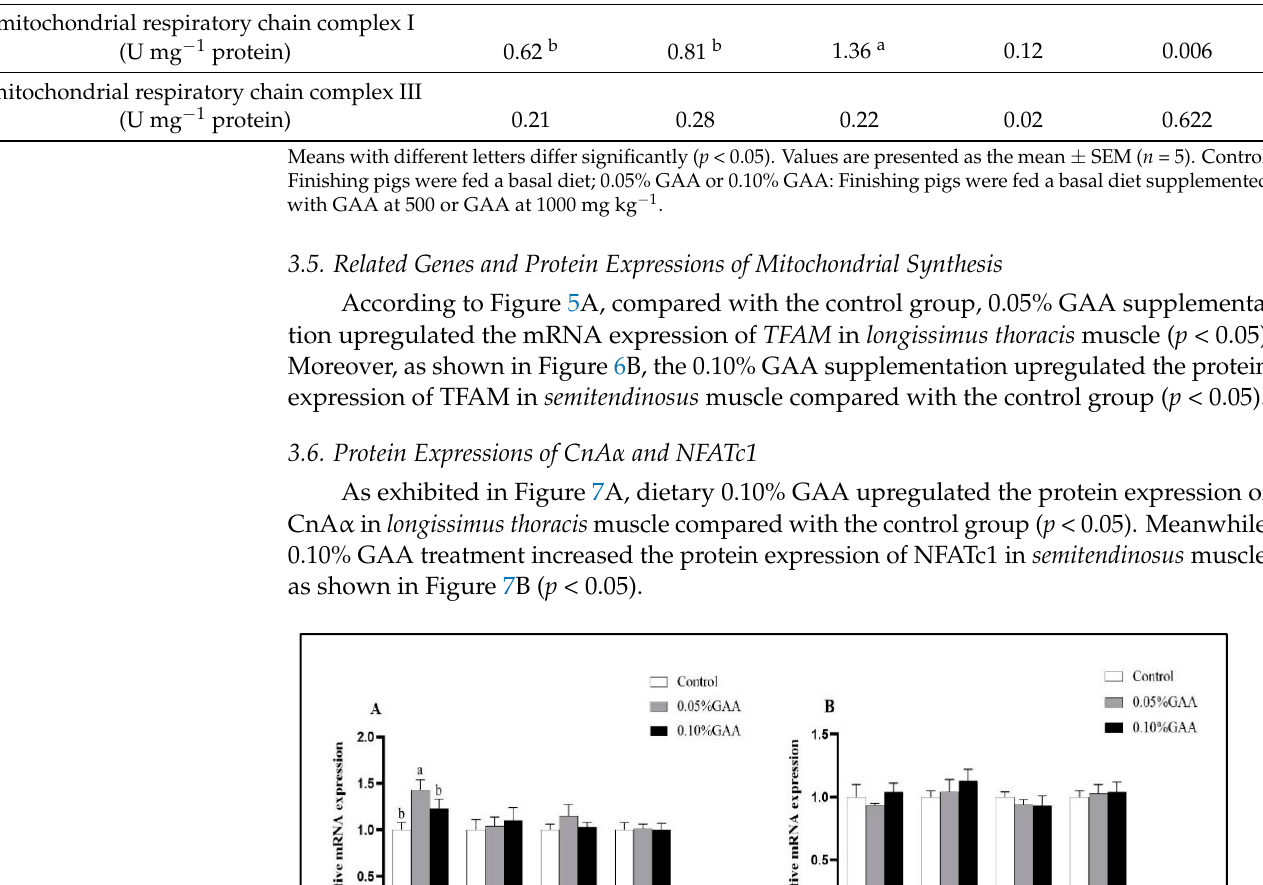
Table 3. Effects of guanidinoacetic acid supplementation on the activities of mitochondrial respiratory chain complex I and III in the longissimus thoracis and semitendinosus muscle of finishing pigs. Item Control